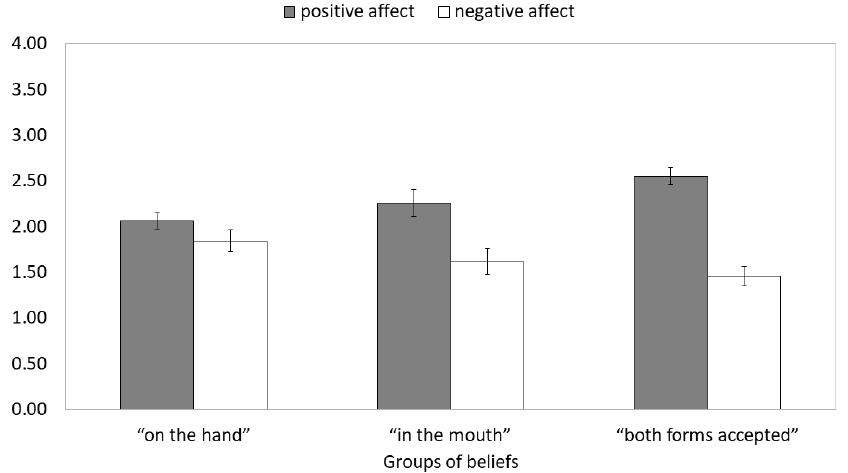
Figure 1. Positive and negative reactions toward the whole Church community and beliefs about the proper form of reception of Holy Communion during the COVID-19 pandemic.